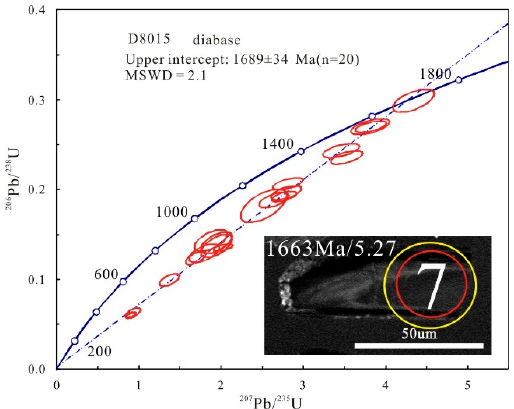
Figure 8. CL images and concordia plots of zircon U–Pb dating for diabase (D8015). Figure 9. CL images and concordia plots of zircon U–Pb dating for diabase